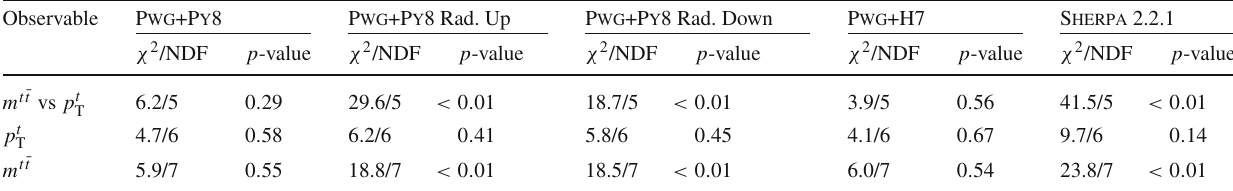
Table 26 Comparison of the measured parton-level absolute differen- tial cross-sections in the boosted topology with the predictions from several MC generators. For each prediction a χ 2 and a p -value are